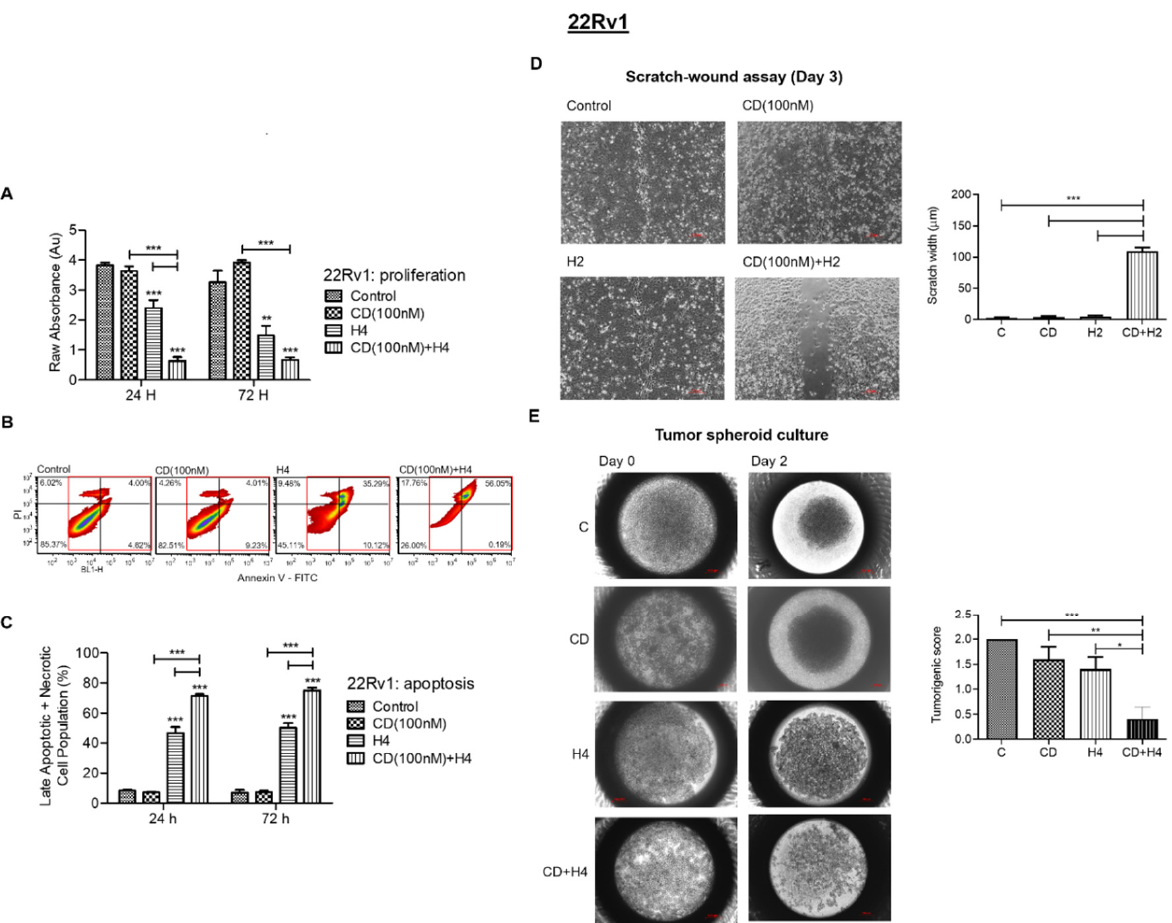
Figure 4. Effect of FUS, alone and in combination with CDDO-me, on cell viability, cell death, migration and spheroid formation in 22Rv1 cells. In ( A ), cell proliferation (WST-8 assay) at 24 h and 72 h post treatment with CDDO-me (100 nM) or FUS (H4), alone and in combination, is shown. ( B ) flow cytometry analysis of C4-2B cells exposed to CDDO-me (100 nM) or FUS (H4), alone and in combination. The percentage of early apoptotic/necrotic cells (PI+/FITC+) is shown in the upper right quadrant. The late apoptotic/necrotic 22Rv1 cells, as a percentage of total cell population, is shown in panel ( C ). ( D ) effect of low-dose FUS (H2), alone and in combination with CDDO-me (100 nM), at day 3 post treatment. Representative images of day 0 (top) and day 3 (bottom) wound width are shown on the left, and bar graph data on wound width at day 3 are on the right ( n = 4). Data show a significant ( p < 0.001) suppression in migratory properties of 22Rv1 cells following combined treatment. ( E ) effect of combination treatment (CD + H4) on spheroid formation by 22Rv1 cells at day 2 of the spheroid culture. Representative images of spheroids and bar graph data ( n = 5) are shown on the left and right, respectively. Significant changes from untreated controls or individual treatment groups are represented as p -values (* p < 0.05; ** p < 0.01; and *** p < 0.001).